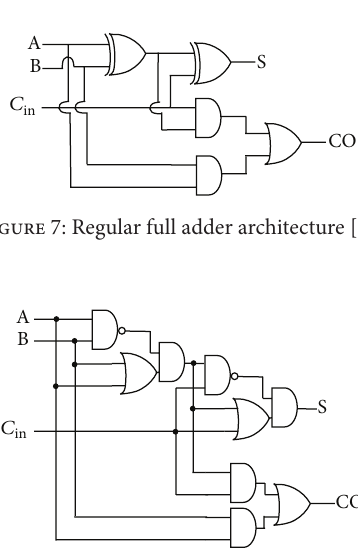
Figure 8: Reconfigured full adder